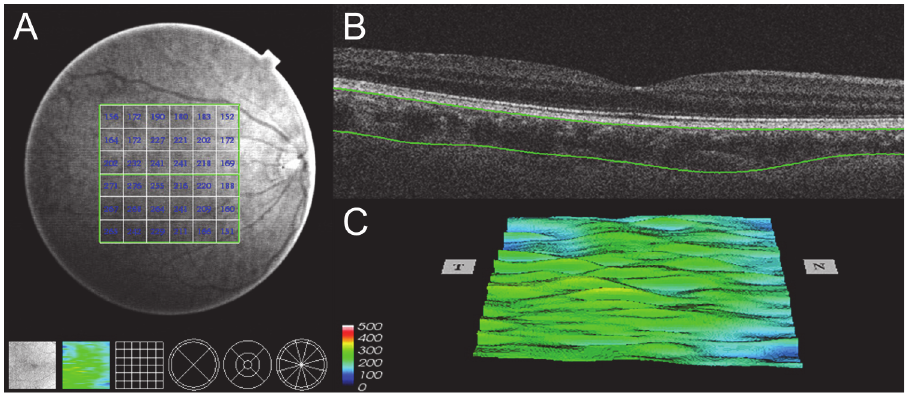
Fig 2. SS-OCT measurement. SS-OCT image showing the measurements of choroidal thickness. (A) Choroidal thickness map of the 6×6 mm area centered on the fovea was created. The mean choroidal thickness was obtained for each sector. (B) Automatic placement of the chorioscleral border made by the automatic built-in software in one of the B-scan images of the 3D data set. (C) Choroidal topographic map of the 6×6 mm